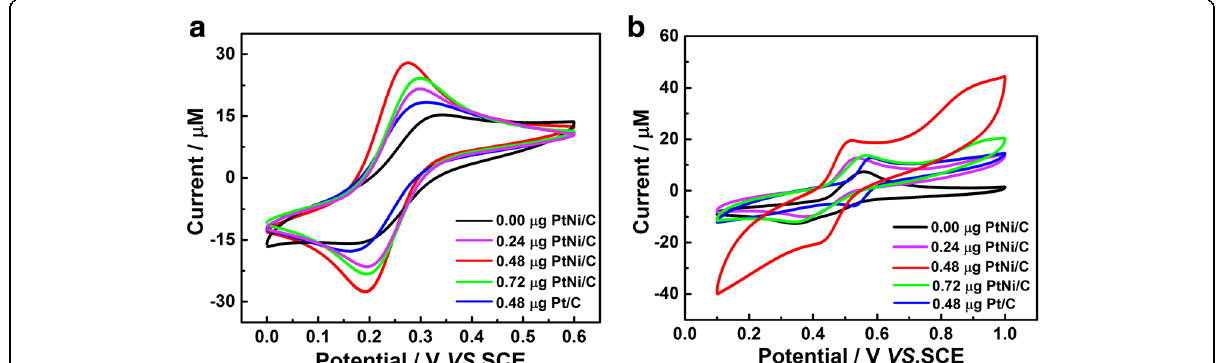
Fig. 2 The CVs of 0 μ g, 0.24 μ g, 0.48 μ g, and 0.72 μ g PtNi/C and 0.48 μ g Pt/C-modified GCE in 0.5 mM K 3 [Fe (CN) 6 ]/ K 4 [Fe (CN) 6 ] containing 0.1 M KCl ( a ) and in 0.1 M BR buffer solution (pH = 2.0) containing 0.5 mM CA ( b ) at a scan rate of 100 mV s −